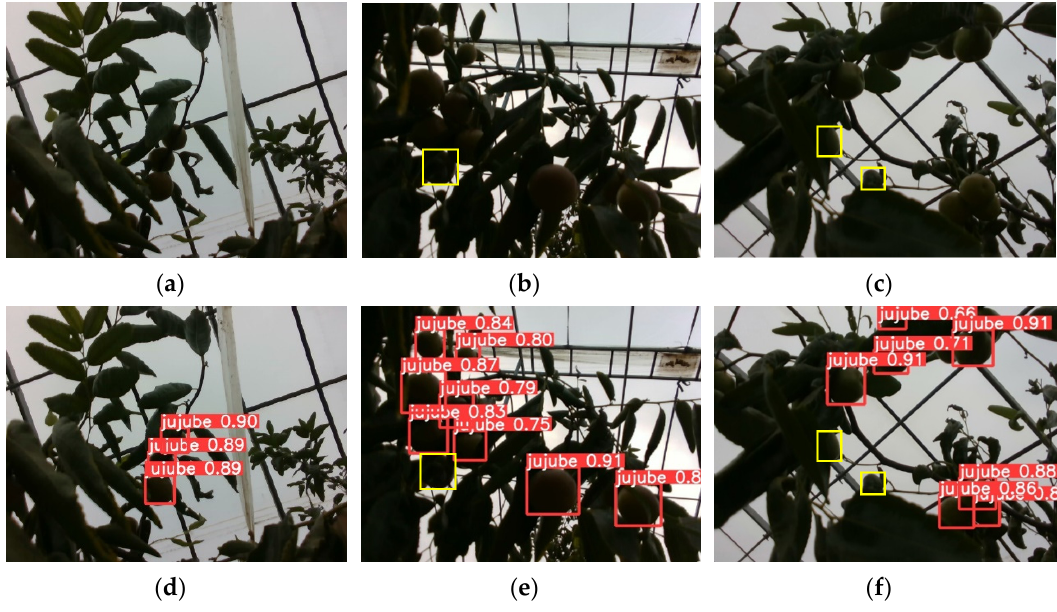
Figure 14. Original image and test results of different scenes in dim light conditions. ( a ) Scene 1; ( b ) Scene 2; ( c ) Scene 3; ( d ) test results of scene 1; ( e ) test results of scene 2; ( f ) test results of scene 3. The yellow boxes are the label boxes marked manually of unidentified winter